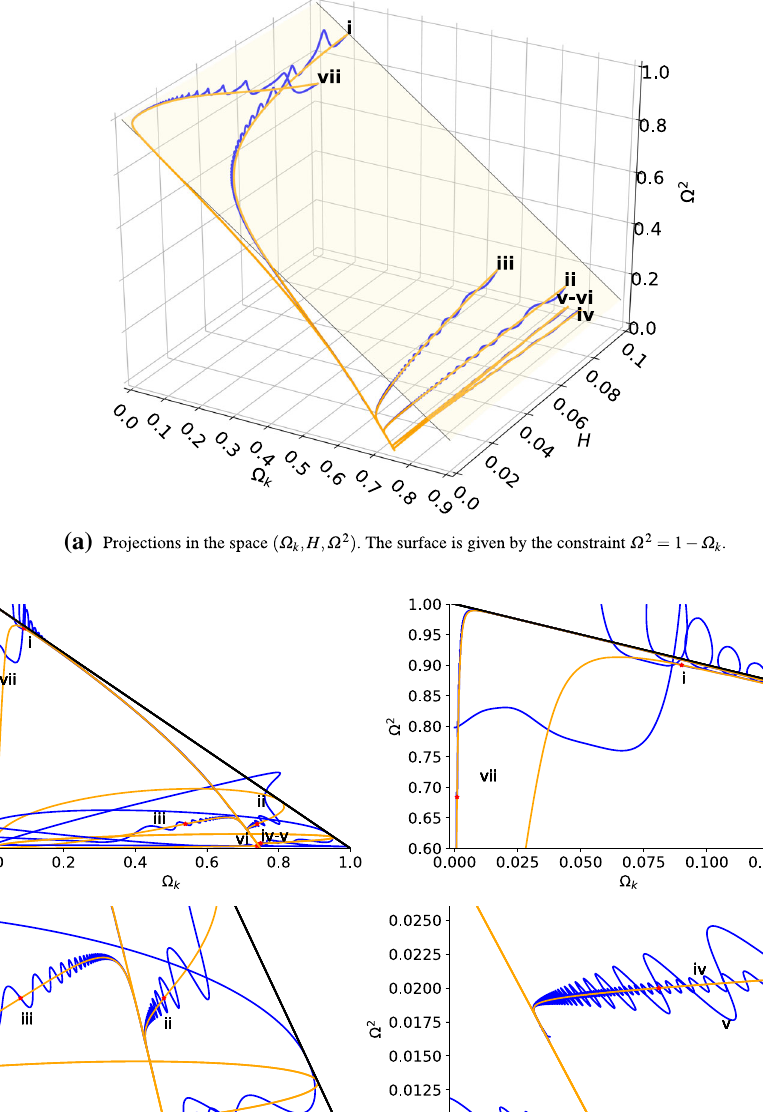
Fig. 20 Some solutions of the full system (46) (blue) and time-averaged system (78) (orange) for the LRS Bianchi III metric when γ = 2, in the projection Σ = 0. We have used for both systems initial data sets presented in the Table